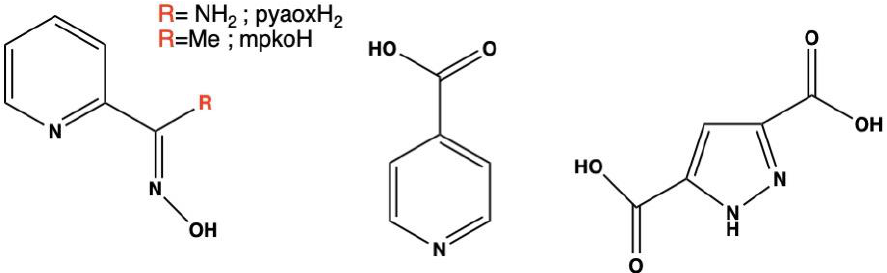
Scheme 1. Schematic representation of 2-pyridyl oximes (left), isonicotinic acid (centre) and 3,5-pyrazole dicarboxylic acid (right).